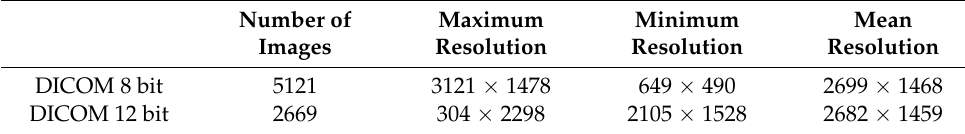
Table 1. Resolution of total database